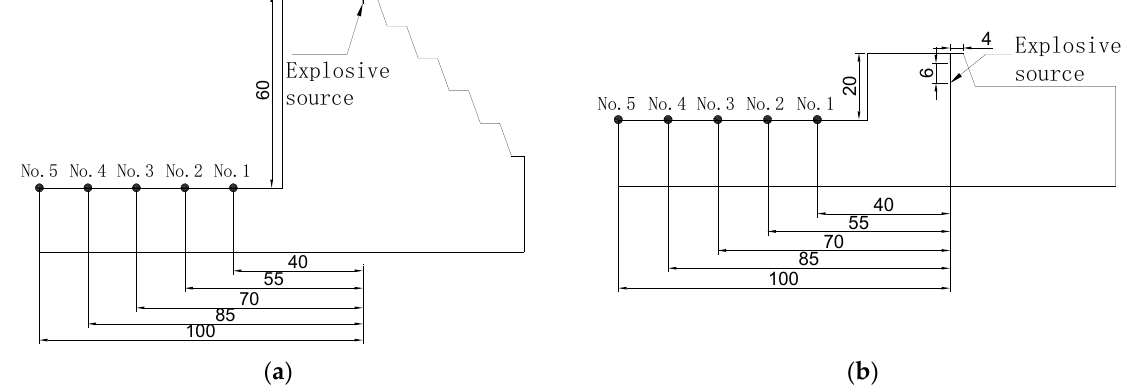
Figure 2. Monitoring scheme for 60 m and 20 m bench height monitoring points. ( a ) Bench height is 60 m. ( b ) Bench height is 20 m. Table 1. Monitoring scheme.